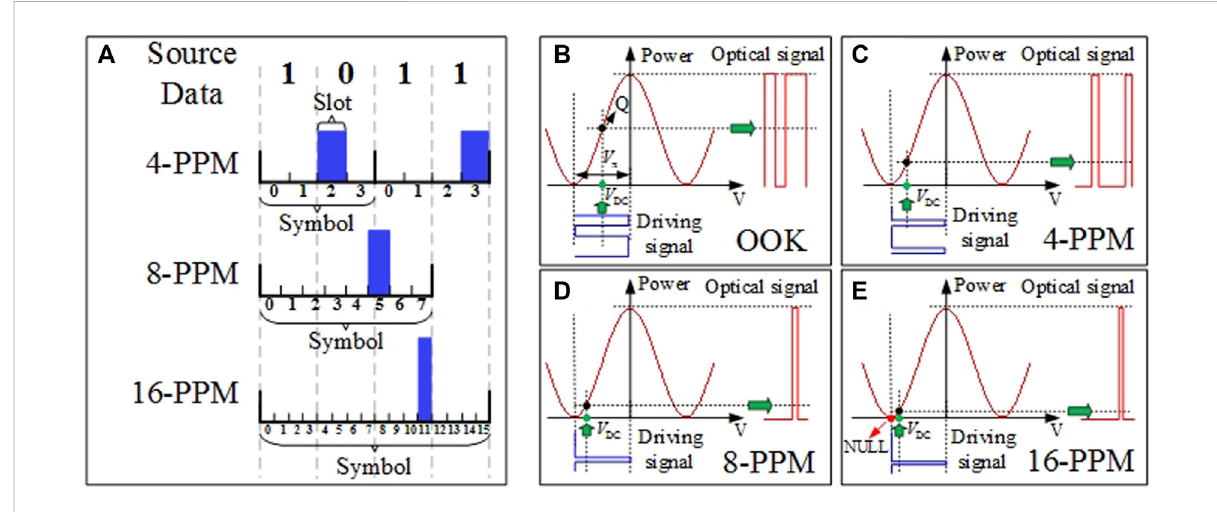
FIGURE 1 (A) Code mapping of the M -PPM ( M = 4, 6, and 8) modulation format. (B – E) MZM transmission characteristics curves of OOK, 4-PPM, 8-PPM, and